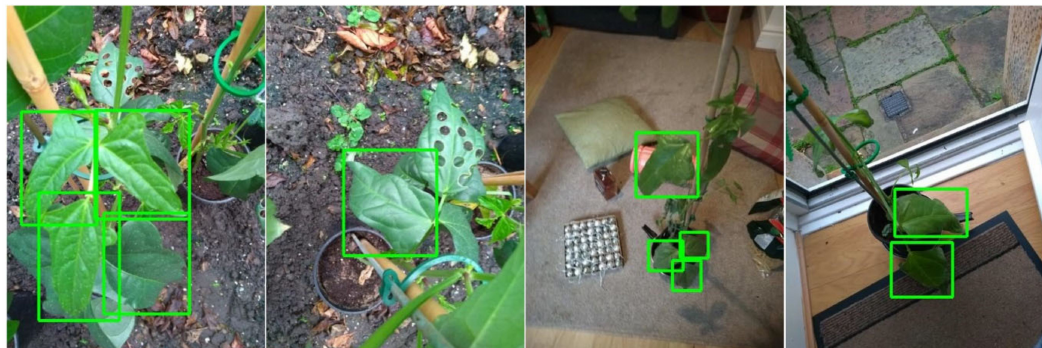
Figure 5. Four example pictures used for training the neural network. Leaves were only selected if they were not occluded or cropped—the method for estimating position is reliant on full leaves being labelled by the